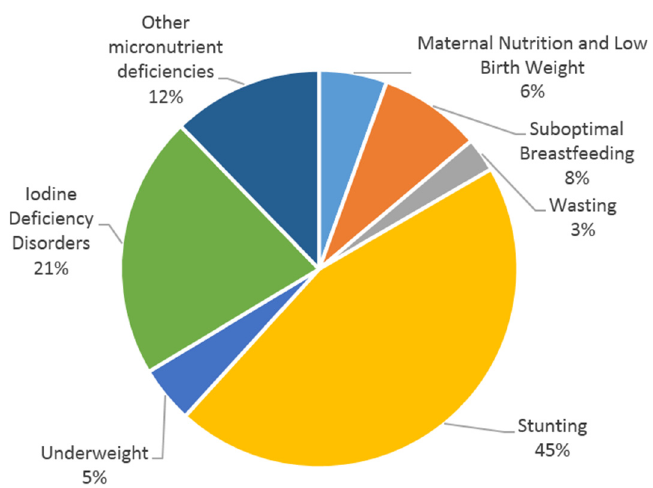
Figure 1. Impact of discount rates on economic burden of malnutrition.